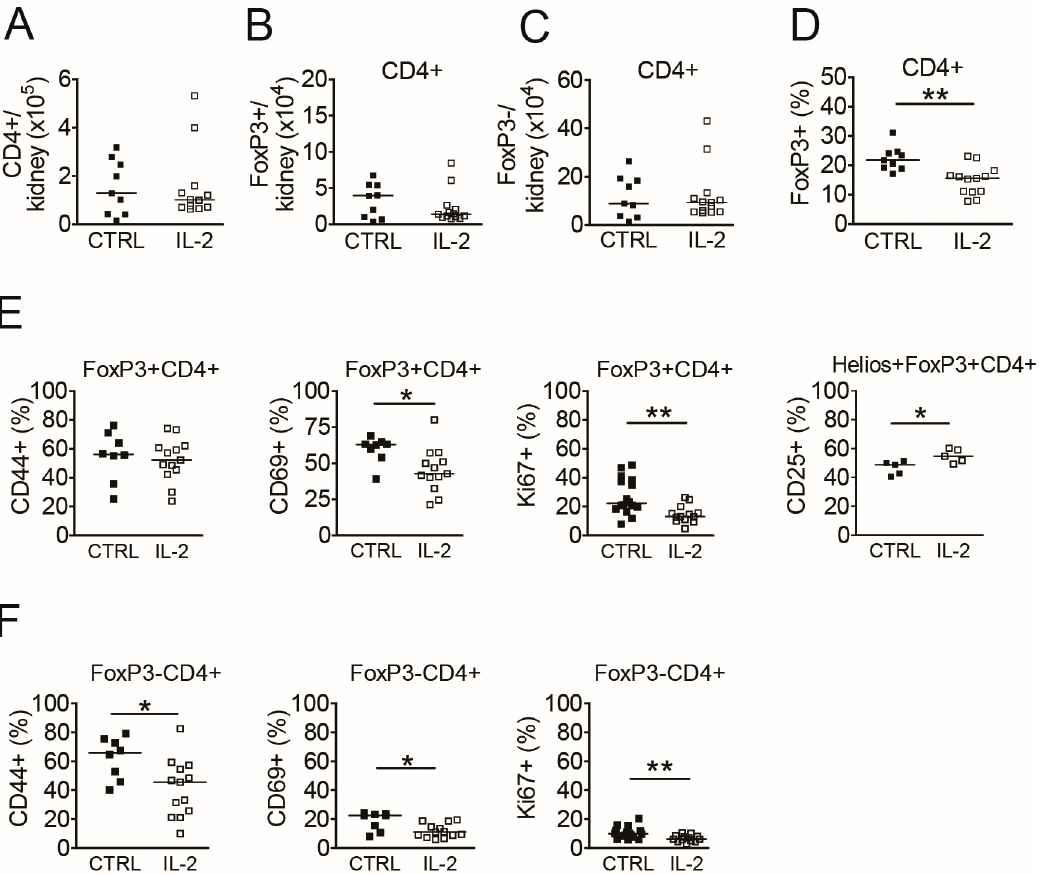
Figure 5. Long-term IL-2 treatment diminishes the activity and proliferation of intrarenal Treg and Tcon. Cells from kidneys of (NZB × NZW) F1 mice with active nephritis were analyzed by flow cytometry at day 31 after the initiation of the IL-2 treatments (48 h after the last IL-2 injection; IL-2, white bars) and were compared to PBS-treated control mice (CTRL, black bars). ( A – D ) Scatter plots show the absolute numbers of total CD4 + T cells ( A ), of CD4 + FoxP3 + Treg ( B ) and of CD4 + FoxP3 − Tcon ( C ) and the percentage of FoxP3 + cells among CD4 + T cells in kidneys ( D ). ( E – F ) The percentages of CD25 + , CD44hi, CD69 + and of Ki67 + cells among intrarenal CD4 + FoxP3 + Treg ( E ) and among intrarenal CD4 + FoxP3 − Tcon ( F ) are shown. Filled squares indicate PBS treated control mice (CTRL; n = 8) and open squares represent IL-2 treated mice (IL-2, n = 13). Horizontal lines indicate the median of each group. Data are the summary of two to five independent experiments. Mann-Whitney U test was used for statistical analyses (* p < 0.05 and ** p < 0.01).